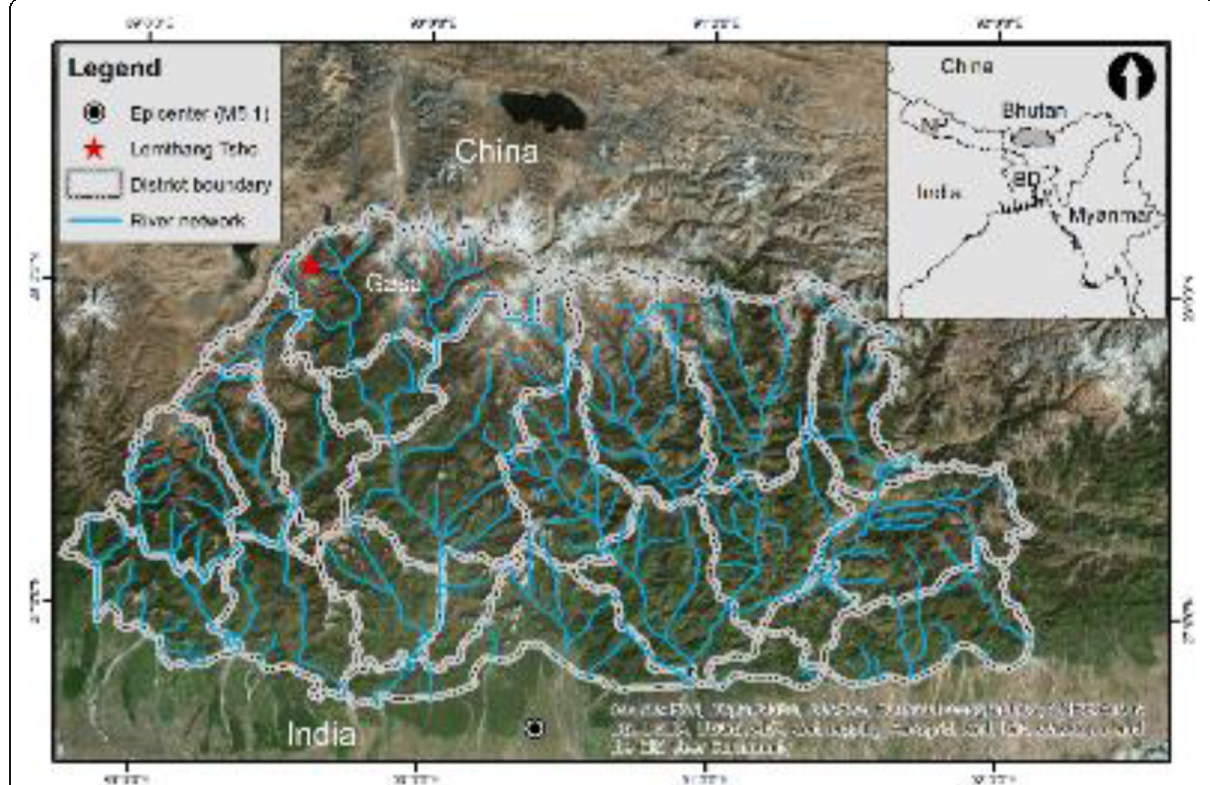
Fig. 1 Map of Bhutan showing the location of Lemthang